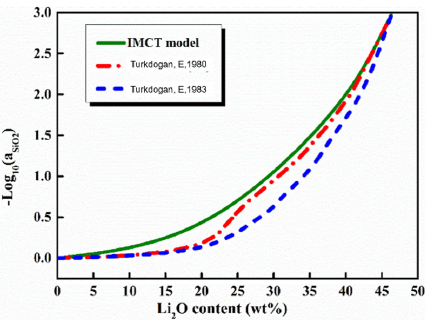
Figure 2. Activities of SiO 2 estimated by the IMCT model and sub-regular solution model for Li 2 O- SiO 2 binary system. Li 2 O-SiO 2 binary